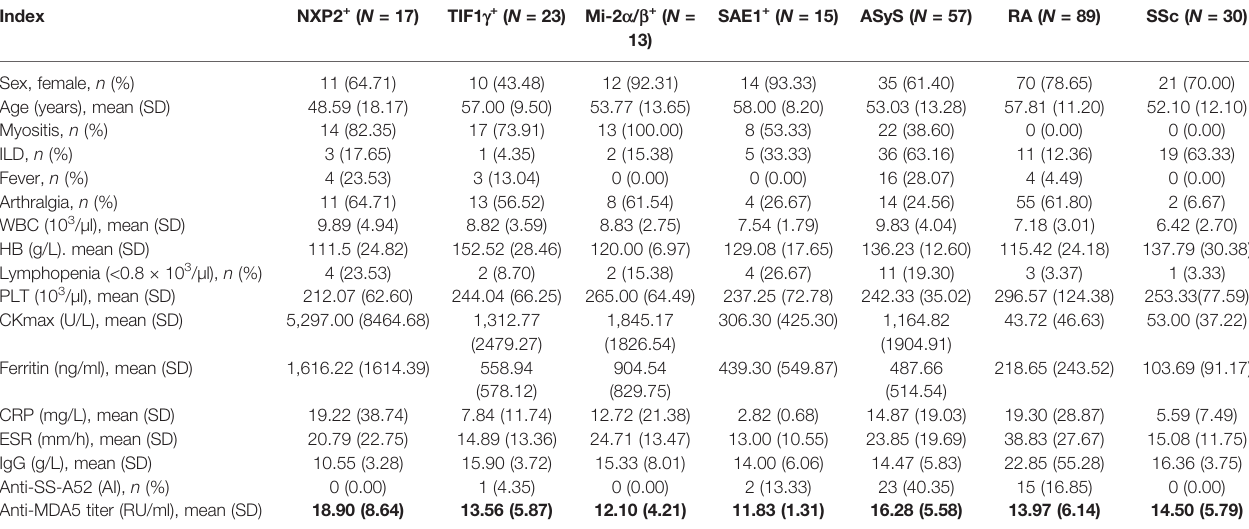
TABLE 2 | Clinical and serological characteristics of patients with MDA5 − dermatomyositis (DM) and others.